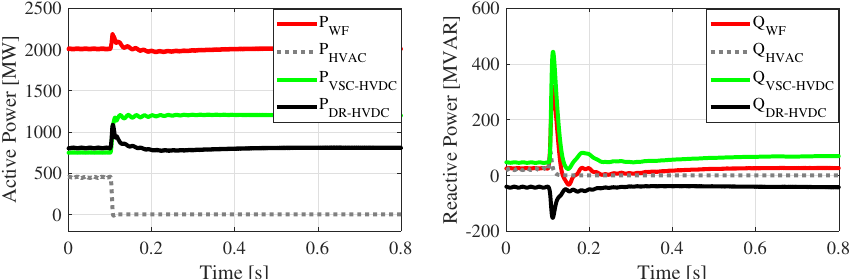
Figure 5. Active ( left ) and reactive ( right ) power of OWF and transmission lines when the HVAC link trips.